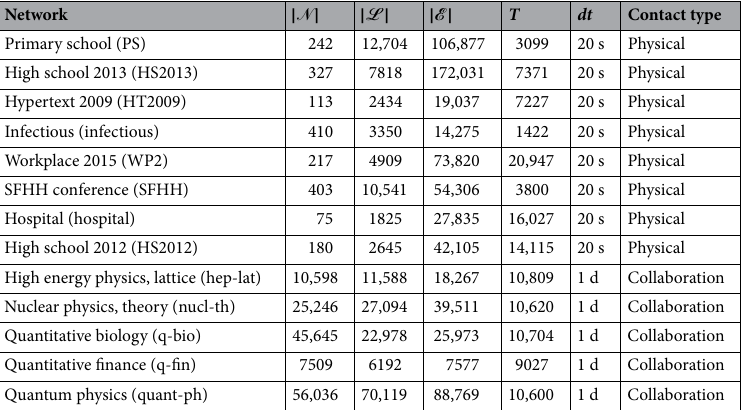
Table 1. Basic features of the empirical higher-order time-evolving networks after data processing. The number of nodes ( | N | ), the number of hyperlinks ( | L | ), the total number of events ( | E | ), the length of the observation time window in time steps ( T ), the time resolution or duration of each time step ( dt ) in seconds or days and the contact type are